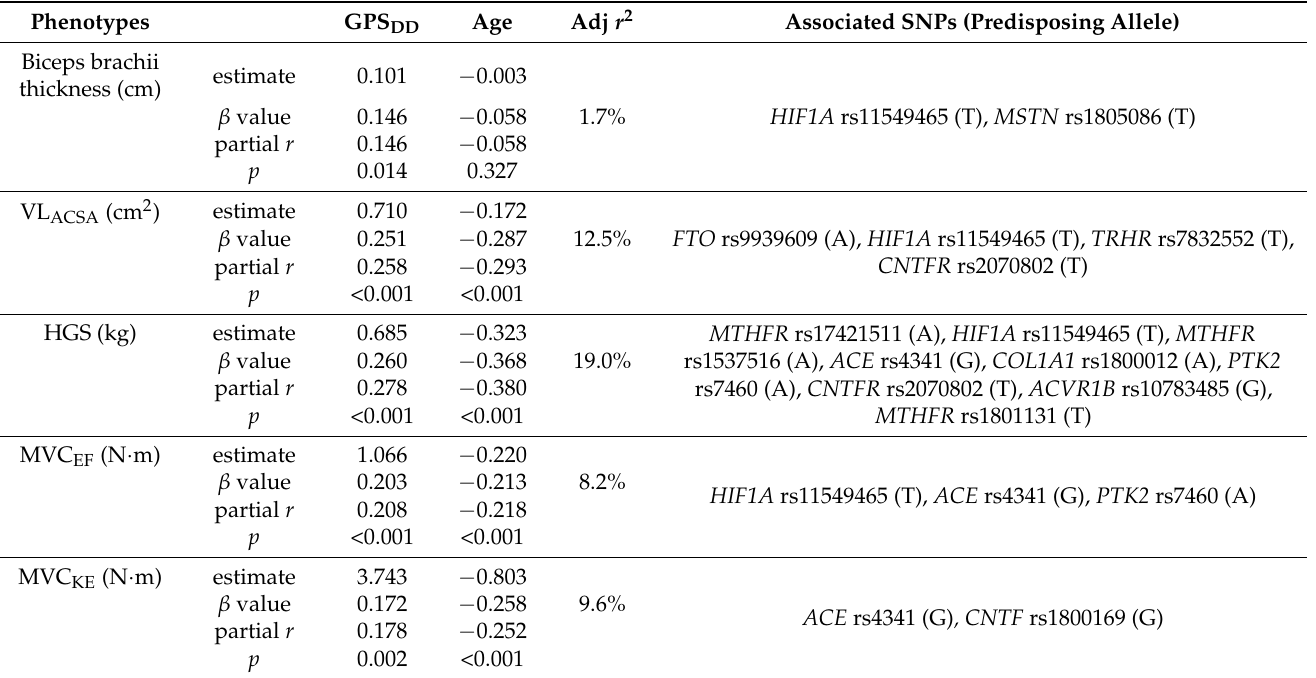
Table 2. Regression models for GPS DD and skeletal muscle phenotypes including age as an indepen- dent variable.